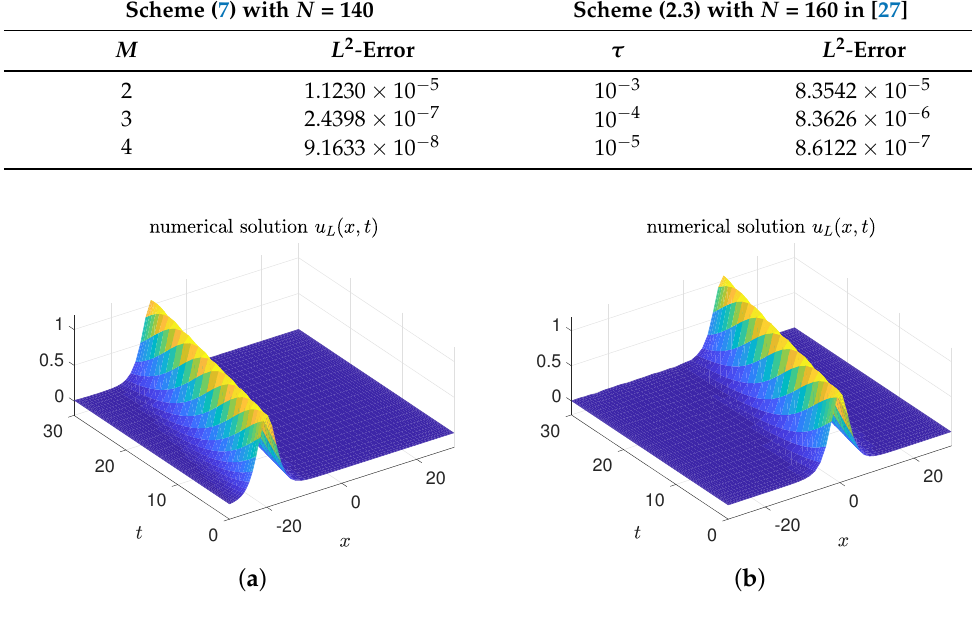
Figure 4. Time evolution of the numerical solutions for Example 2 with different constant x 0 . Take a = − 30, b = 30, κ = 0.3. ( a ) x 0 = − 20; ( b ) x 0 =